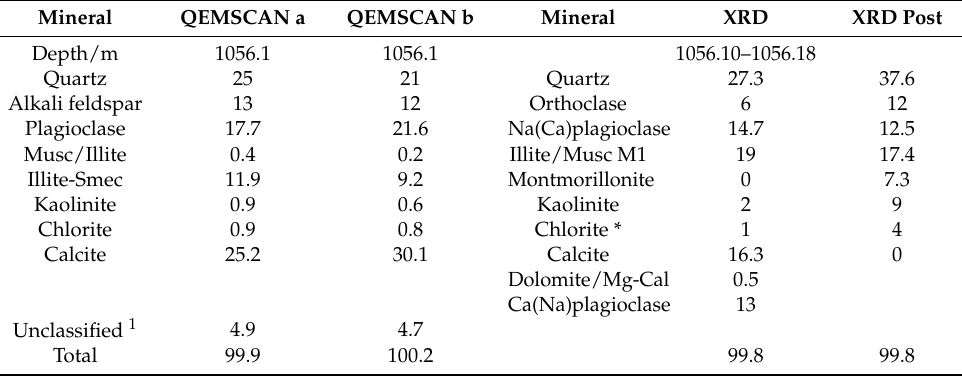
Table 1. Quantified minerals in the cap-rock from 1056.10–1056. 18 m. Where QEMSCAN was previously reported on two adjacent sub-plug slices [29] and is reported in area %. XRD was performed on a powdered section of the whole core, and also on the subsample after reaction, reported in wt. %. * Fe-rich